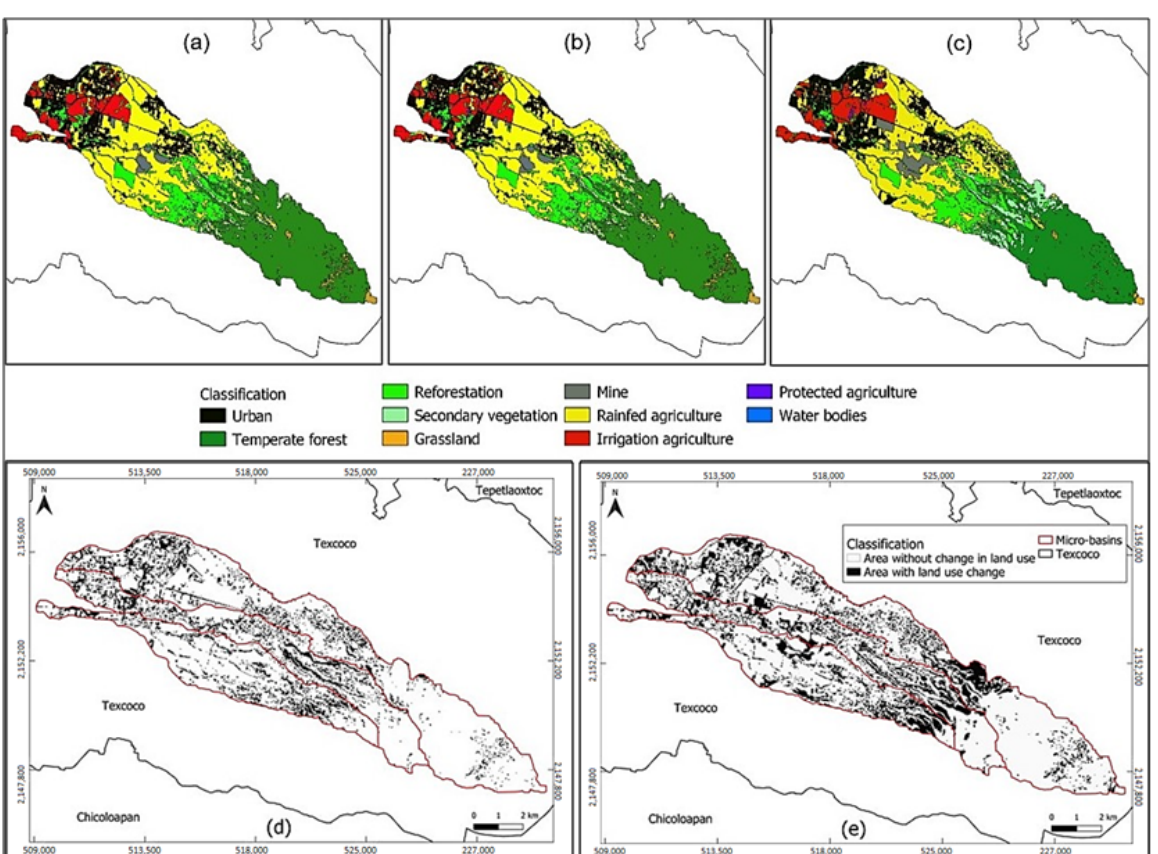
Figure 3. Land use and vegetation in year 1995 ( a ), 2008 ( b ) and 2021 ( c ). Areas with land use change in period: ( d ) 1995–2008 and ( e )